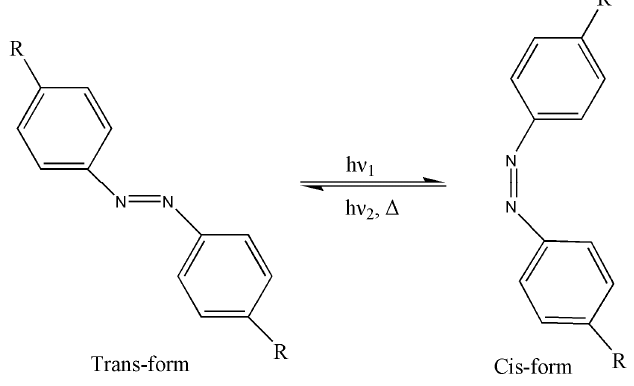
Figure 7. Schematic figure of the trans - cis isomerization of azobenzen.